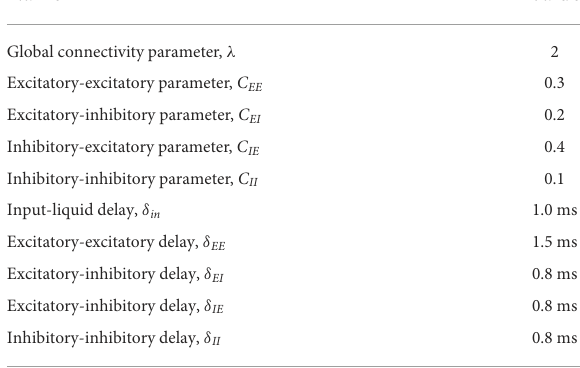
TABLE 2 Liquid state machine model setup: Parameter names and corresponding